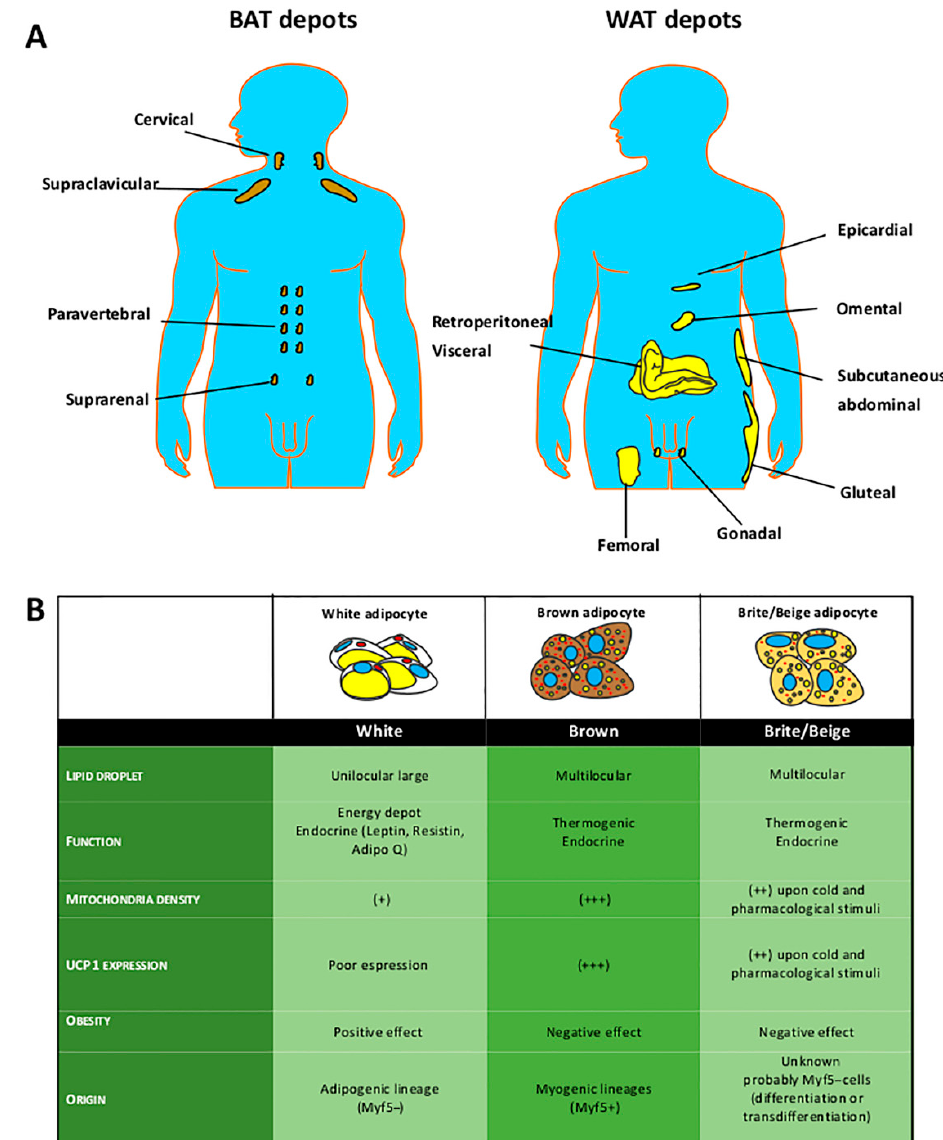
Figure 1. White, brown, and brite/beige adipose depots. ( A ) Body distribution of subcutaneous (gluteal, abdominal, and femoral), visceral (gonadal, mesenteric, epicardial, omental, and retroperitoneal), and brown (paravertebral, supraclavicular, and suprarenal) adipose tissue depots in a human model. BAT: brown adipose tissue; WAT: white adipose tissue. ( B ) Comparison among white, brown, and brite/beige adipose tissue.